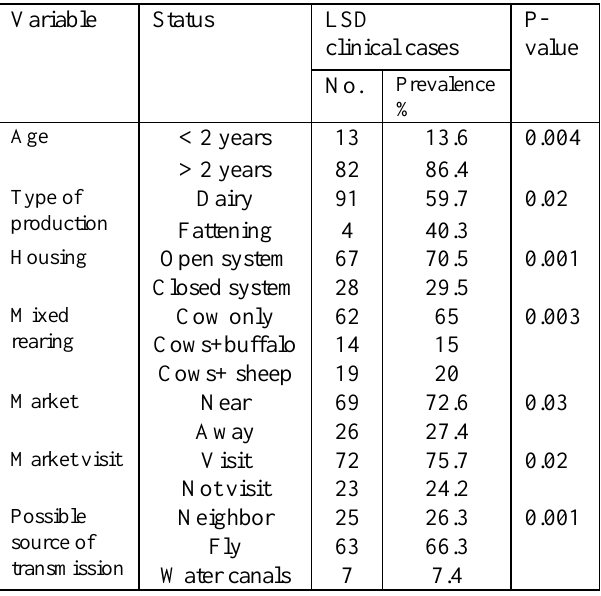
Table 3: Effect of production factors on prevalence